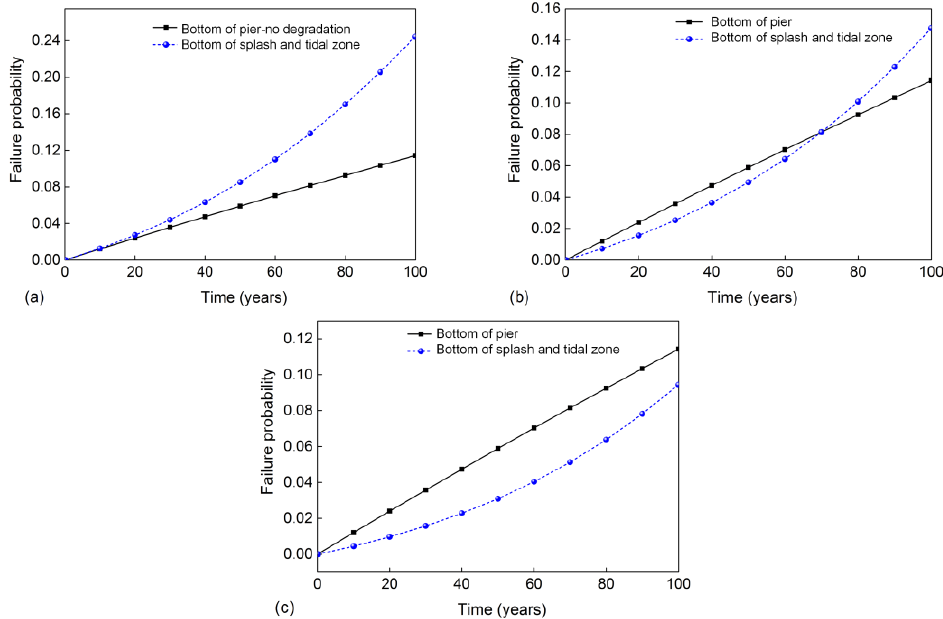
Figure 16. Time-dependent failure probability of pier sections: ( a ) case 1; ( b ) case 2; ( c ) case 3. On the basis of the sectional failure probability, the time-dependent reliability of the whole pier expressed with failure probability can be determined with Equation (25), which is shown in Figure 17. To give the gradual evolutionary trend of the time-dependent failure probability curve, the cases of submerged zone height L sub = 1.0 m and 2.0 m are also calculated and plotted in this figure. It is observed that not only service time but also submerged zone height influence the failure probability of the pier. Additionally, the increase in L sub delays the time when the failure section shifts from the pier bottom to the bottom of the splash and tidal zone. For the cases where L sub increases from 1.0 to 1.5 and 2.0 m, the year of critical section shift increases from about 50 to 70 and 90 years. When L sub is 2.5 m, the shift year is delayed beyond the service year and the failure probability is the same as the pristine pier. From Figure 17, it is also observed that the failure probability of coastal bridge pier decreases with the increase in the submerged zone. At the end of its service life, the failure probability for L sub = 0 m is 0.244, and the corresponding value decreases to 0.178, 0.148, 0.12, and 0.11 for L sub = 1.0, 1.5, 2.0, and 2.5 m, respectively.